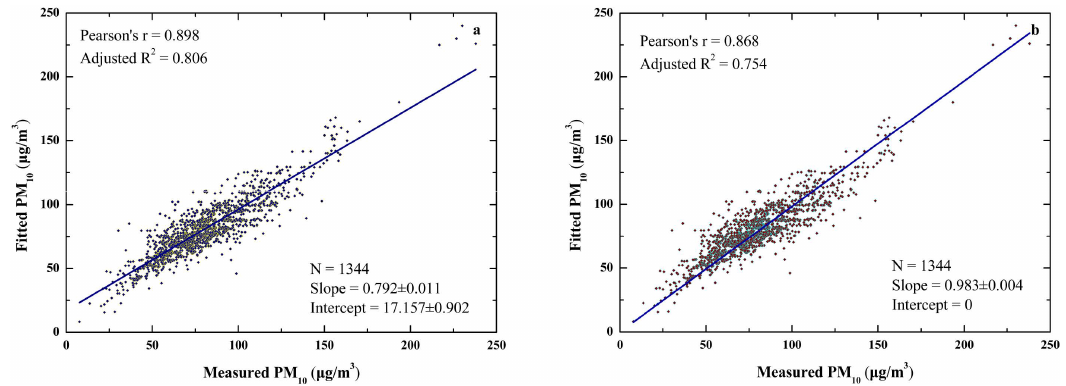
Figure 5. Scatter plot of cross validation for the physics-based GWR model, with conventional linear regression ( a ); and linear regression with intercept fixed at zero ( b